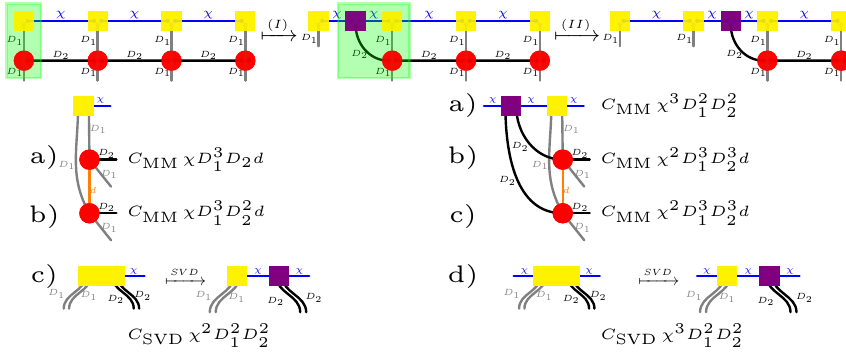
Figure 5: Approximate contraction of a PEPS network on the two-dimensional square lattice with the boundary-MPS method. The first row shows the initial step at the boundary (I) and the bulk-step (II), which is repeated until the right boundary of the network is reached. For simplicity, only a single layer of the two-layer PEPS-network is shown here, but each red circle in the upper row represents the two local PEPS tensors that have to be contracted along the invisible physical dimension. In the second row the detailed contractions of both PEPS-layers that are carried out in each step are depicted with their corresponding computational cost. Lines that terminate in a tensor at a given sub-step ( a)-d)) in a tensor represent the contractions carried out at this point, whereas lines not connected to a tensor at that level correspond to free indices. In total, the scaling is given by ( C